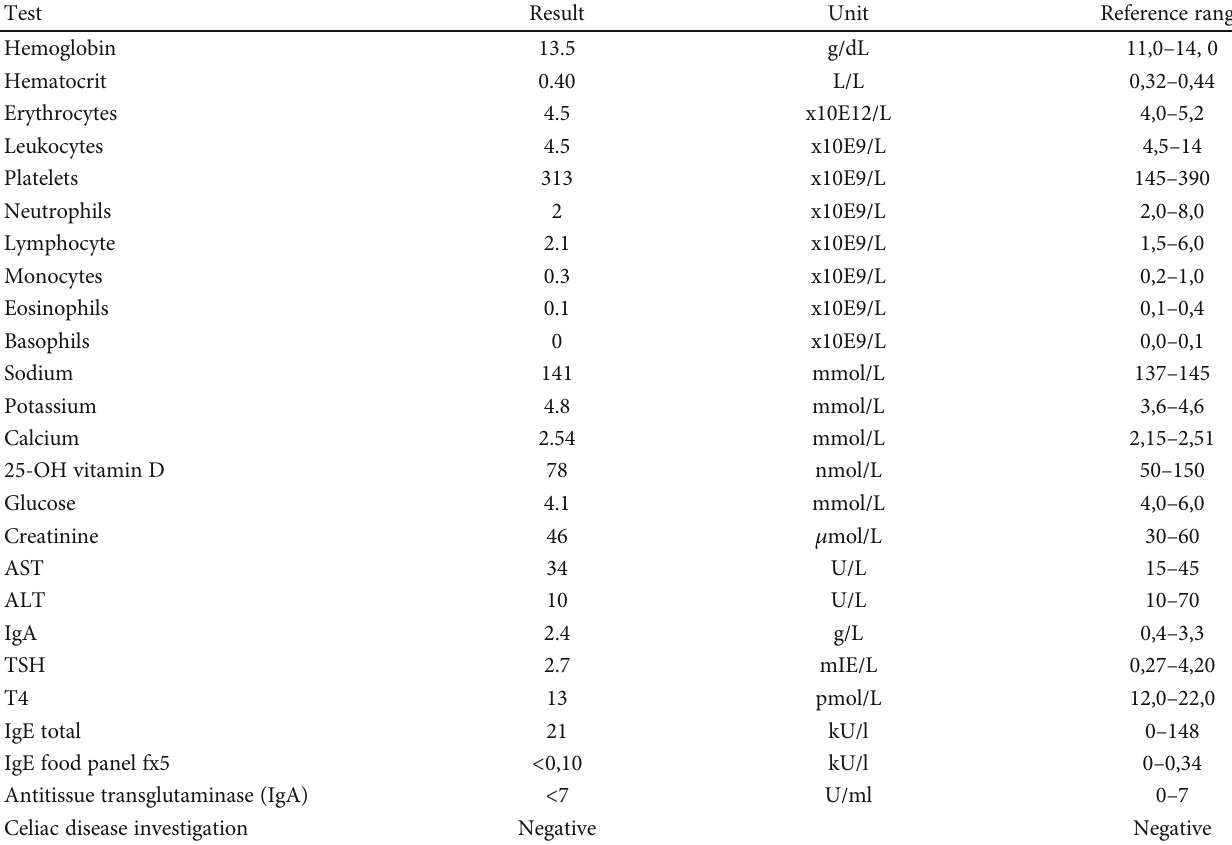
Table 2: Summary of laboratory test